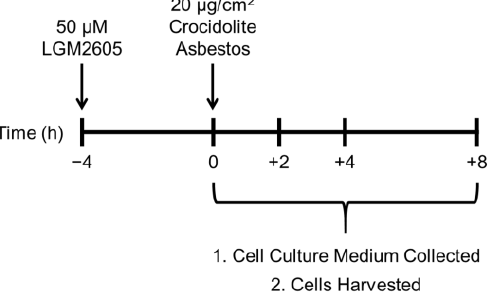
Figure 1. Experimental Plan of Human Pleural Mesothelial Cell Exposure and Harvest Time Points. Human pleural mesothelial cells, derived from a pleural effusion fluid obtained from a single donor, congestive heart failure patient, were plated in a 6-well plate (1 × 10 6 cells/well) and exposed to 50 µM LGM2605 4 h prior to exposure to sterile crocidolite asbestos fibers (20 µg/cm 2 ). Cell culture medium and cells were harvested at 0, 2, 4, and 8 h post asbestos exposure. Cell culture medium was evaluated for ROS release, markers of oxidative and nitrosative stress, proinflammatory cytokine levels, and markers of DNA damage, while cells were evaluated for ROS generation, levels of nuclear factor E2-related factor 2 (Nrf2) and nuclear factor kappa-light-chain-enhancer of activated B cells (NF- κ B) transcription factors, caspase-1 activity, levels of γ H2AX, and DNA single-strand breaks.